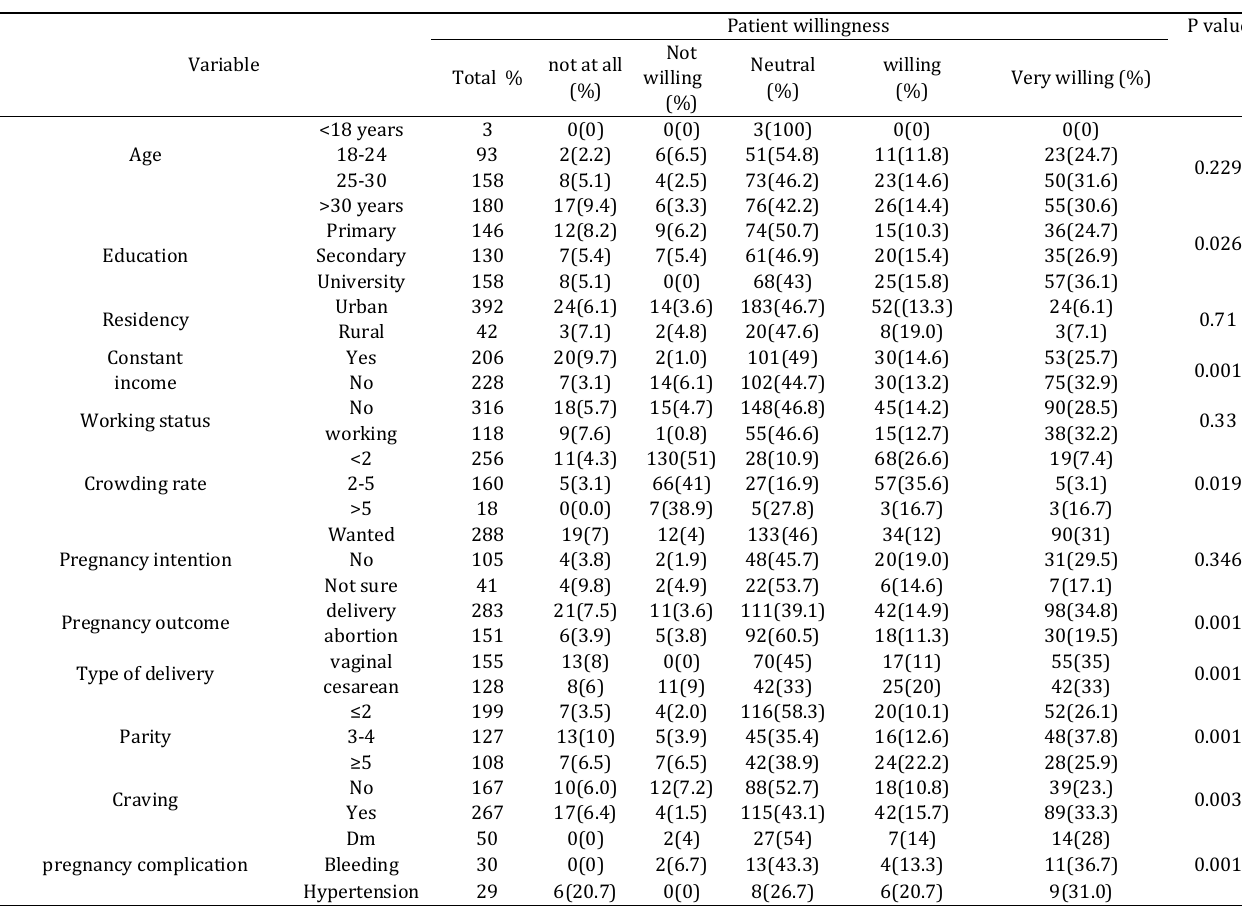
The distribution of study group characteristics according to patient willingness to use immediate post-partum/ abortion contraception: